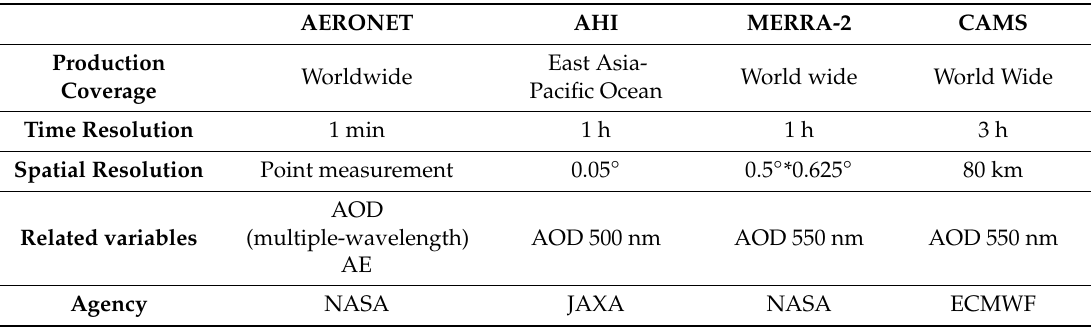
Table 1. Description of Aerosol Optical Depth (AOD)